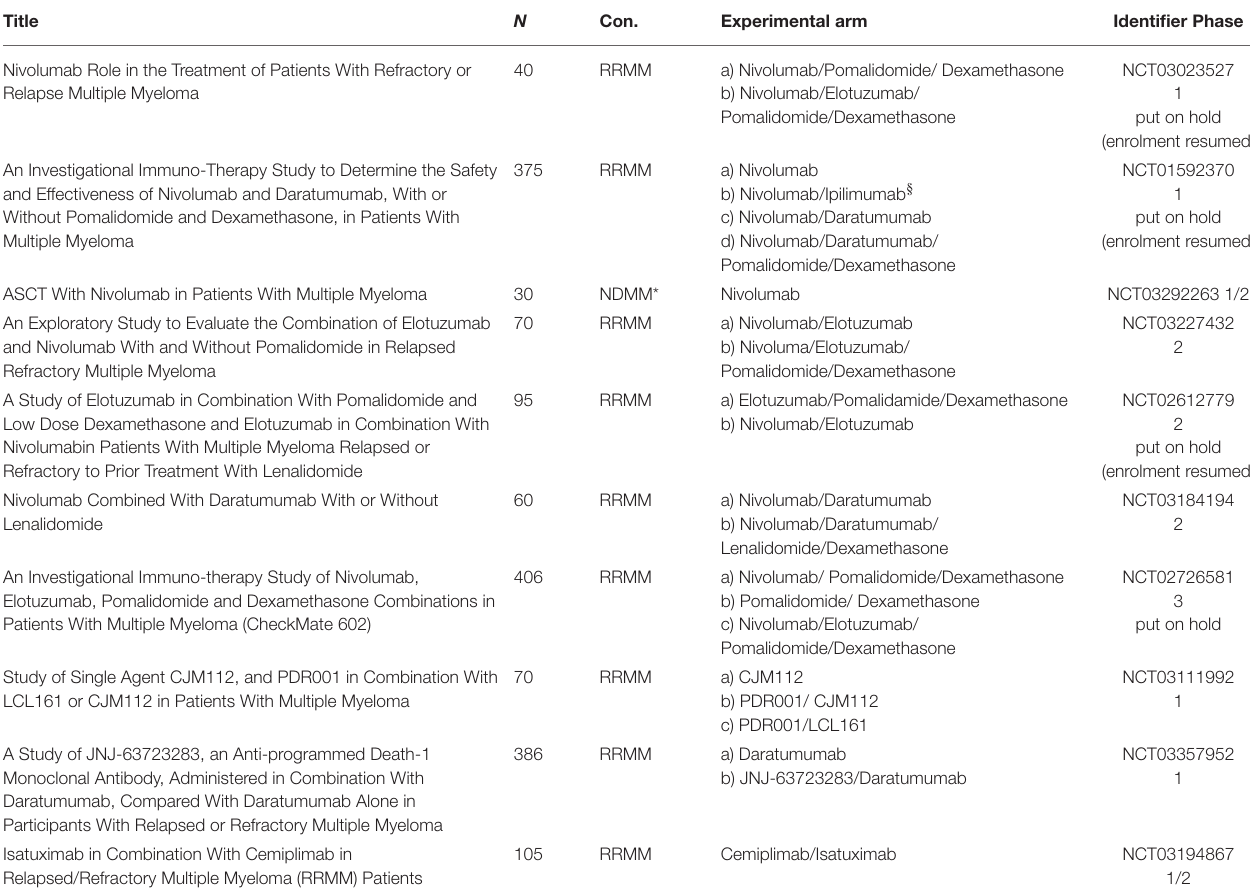
TABLE 2 | Ongoing clinical trials with Nivolumab and other anti-PD-1 monoclonal antibodies (PDR001, JNJ-63723283, Cemiplimab) in multiple